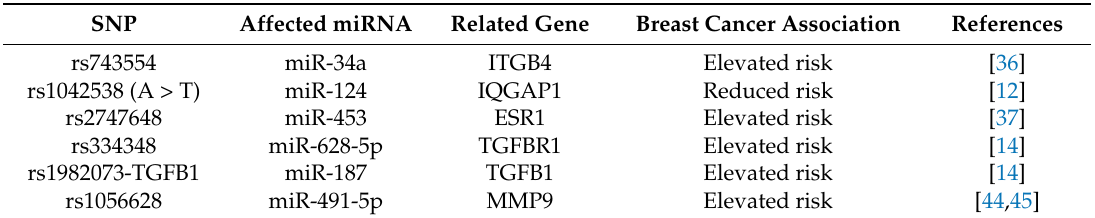
Table 2. miR-SNPs and Related Genes Involved in Breast Cancer